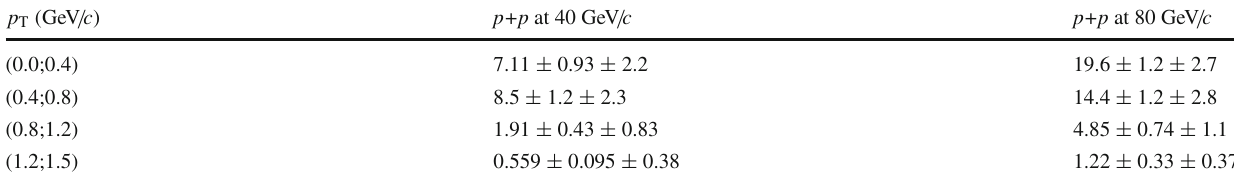
Table 5 The numerical values of double-differential yields d 2 n statistical, while the second one is systematic